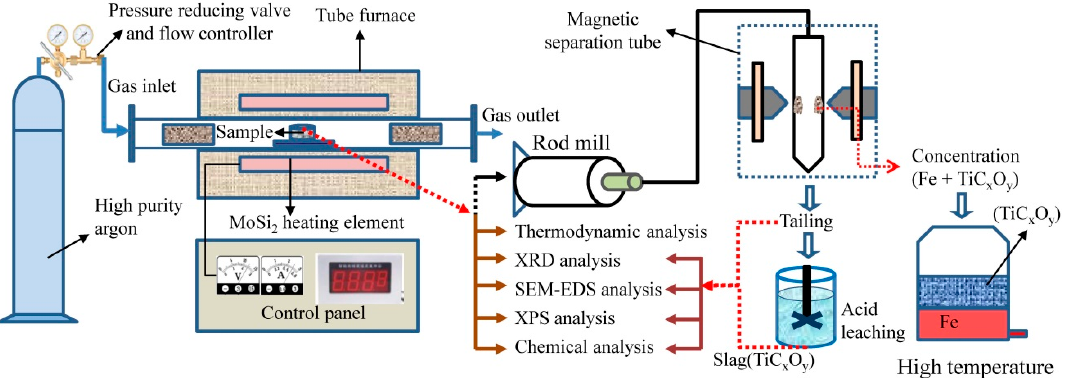
Figure 2. Flow diagram of the whole process .